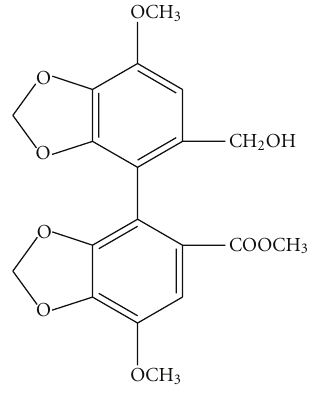
Figure 1: The chemical structure of bicyclol.